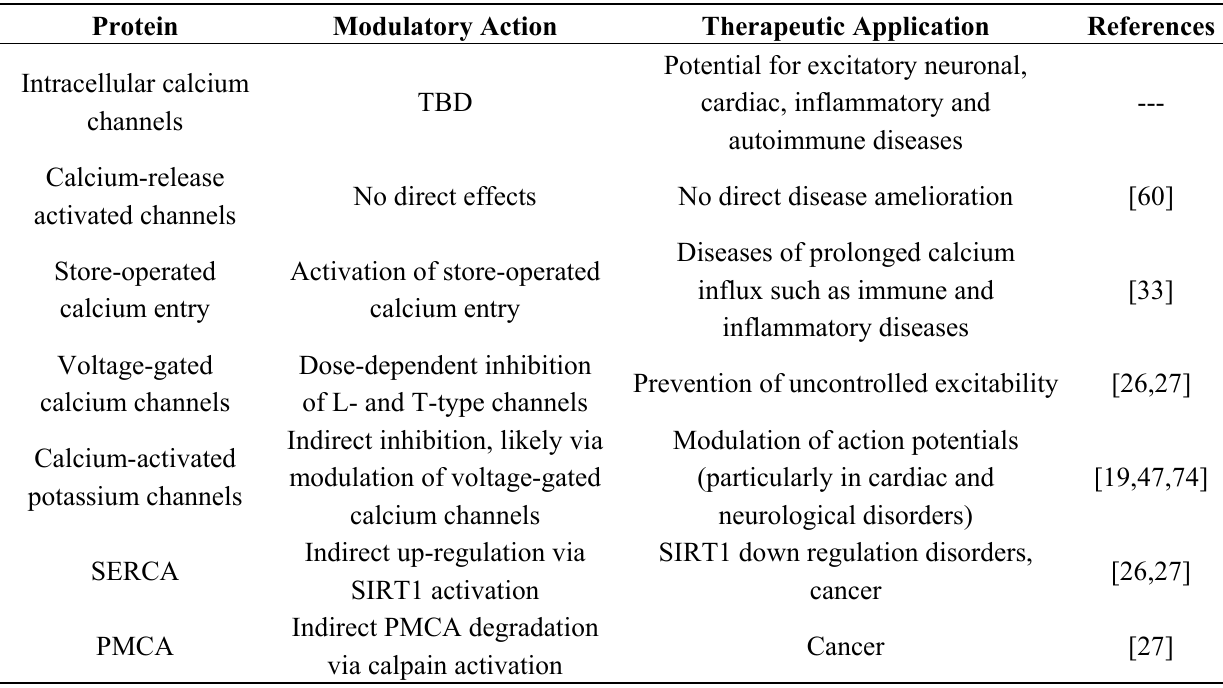
Table 1. Resveratrol’s interactions with cellular proteins and its effects on components of the cellular calcium signaling